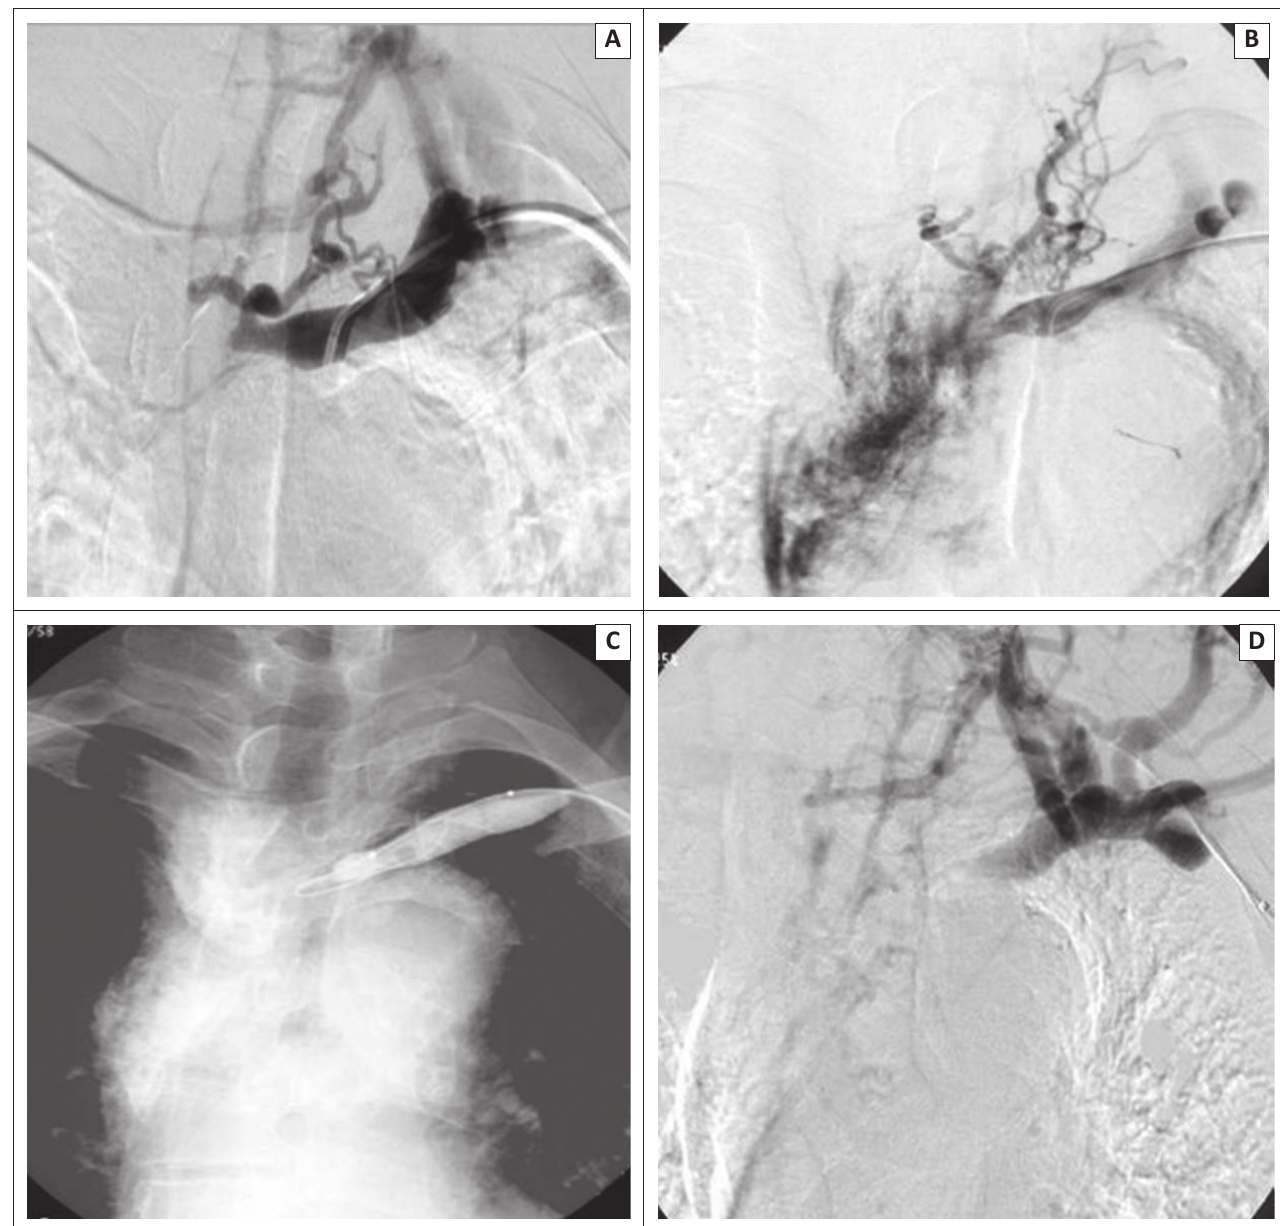
FIGURE 3: A 54-year-old man. Left radio-cephalic fistula. Fistulogram: (a) complete obstruction in the left innominate vein; (b) massive contrast leakage into the mediastinal space because of a guide wire induced innominate vein rupture; (c) balloon occlusion proximal to the rupture site was performed during 10 min, because of failure of guide wire passage through the rupture site; (d) absence of contrast extravasation on the final